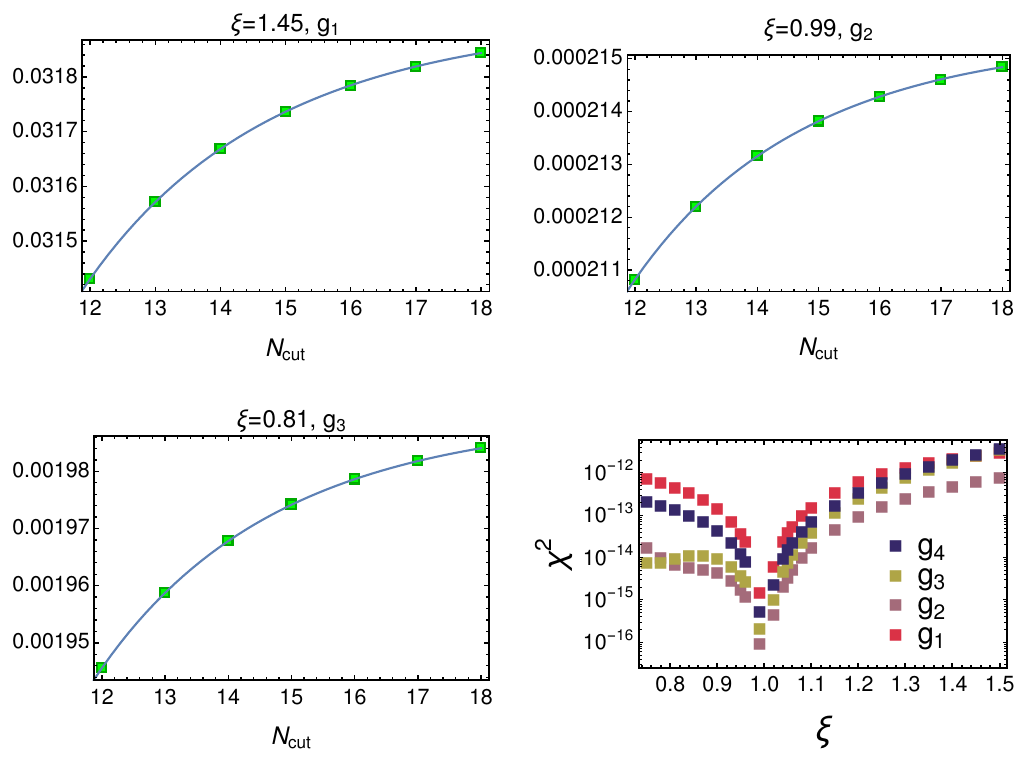
Figure 8 . Illustration of the extrapolation scheme in the case of one-particle overlaps of the Ising Field Theory. The (cid:12)rst three sub(cid:12)gures show that the data can be (cid:12)tted well with the function (4.5). The fourth panel quanti(cid:12)es this observation by displaying the sum of the squared (cid:12)t residuals denoted by (cid:31) 2 as functions of the quench parameter (cid:24) .